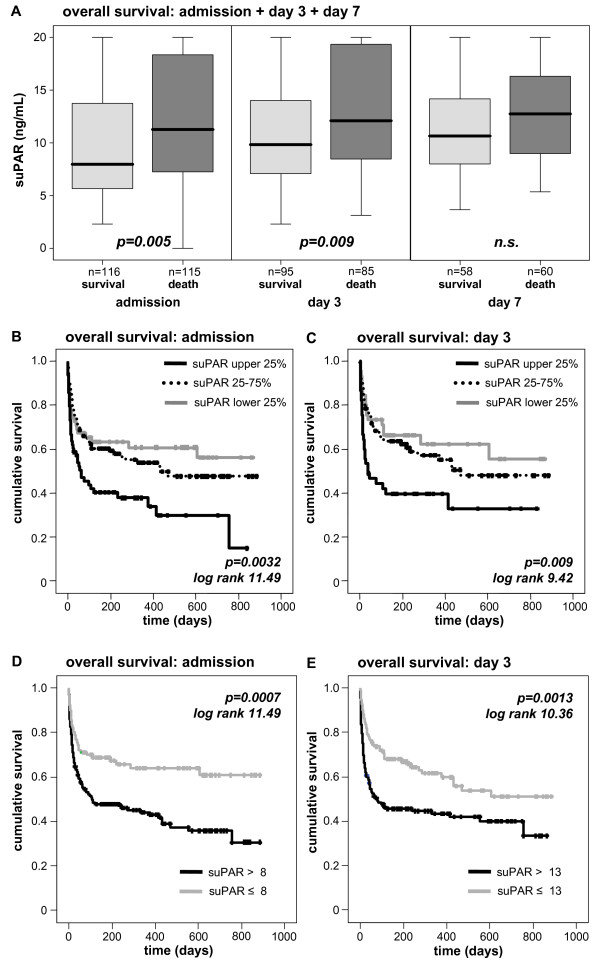
Prediction of long-term mortality by sequential suPAR serum concentrations. (A) Serum suPAR concentrations were significantly associated with the overall survival of critically ill patients. Survivors had significantly lower serum suPAR levels on admittance to ICU (P = 0.005) and on Day 3 (P = 0.009). (B and C) Kaplan-Meier survival curves of ICU patients are displayed, showing that patients with suPAR levels of upper quartile (on admission > 15 ng/mL, on Day 3 > 15 ng/mL; black) had an increased short-term mortality at the ICU as compared to patients with suPAR serum concentrations of lower quartile (on admission < 6 ng/ml, on Day 3 < 7 ng/ml; grey) or middle 50% (dotted line). P-values are given in the figure. (D and E) Kaplan-Meier survival curves of ICU patients are displayed, showing that patients with high suPAR levels (on admission > 8 ng/mL, on Day 3 >13 ng/mL; grey) had an increased overall mortality in the long-term follow-up as compared to patients with low suPAR serum concentrations. P-values are given in the figure.